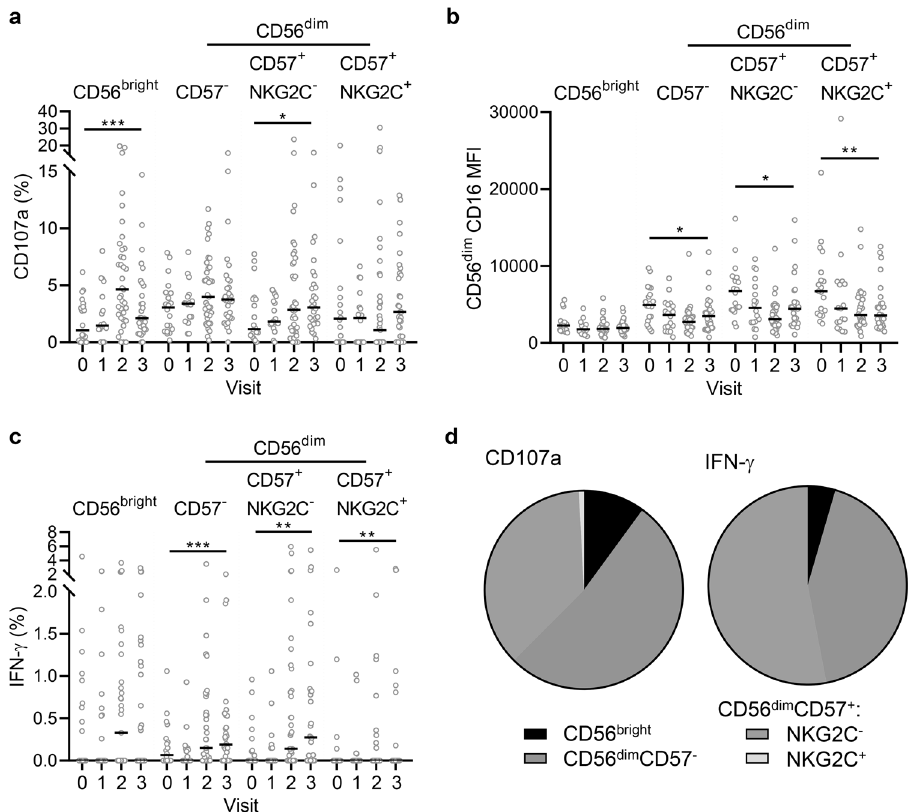
Fig. 5 Subset distribution of antibody-dependent responses induced in multiple NK cell donors and autologous pre/post-vaccination serum. Trial participant NK cell CD107a ( a ), CD16 MFI ( b ), and IFN- γ ( c ) expression in response to autologous pre-vaccination (visit 0), post- dose 1 (visit 1), 14 days post-dose 2 (visit 2) and 180 days post-dose 2 (visit 3) serum for all vaccine arms combined were analysed according to NK cell differentiation subset. Data are pooled for all three vaccine groups (see Table 1 for number of participants), data points are shown with a line representing median values. The proportion of total NK cell CD107a and IFN- γ expression (visit 2) attributed to each subset is shown as a pie graph, with each slice representing the median ( d ). Comparisons across visits were performed using one-way ANOVA mixed effects analysis with Geisser – Greenhouse correction and comparison between subsets was performed using one-way ANOVA with Dunn ’ s correction. * p < 0.05, ** p < 0.01, *** p <